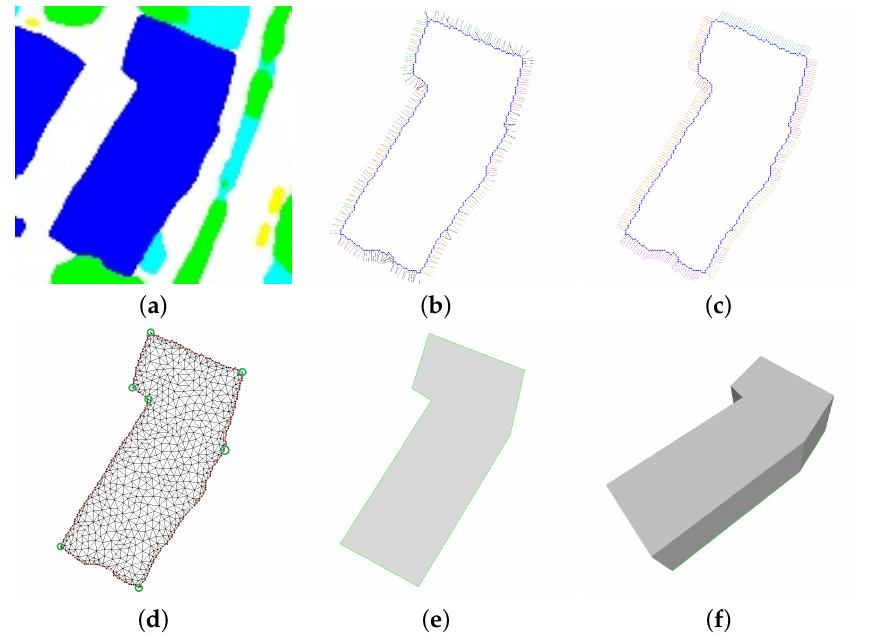
Figure 2. Overview of the proposed method of contour deformation based urban modeling. ( a ) is the input segmentation of a building from Figure 1. ( b ) detects the dominant directions from the bilaterally smoothed normals using RANSAC, five dominant directions are detected (color coded). ( c ) each edge is assigned with a target direction to align to with a Markov random field (MRF) formulation. ( d ) aligns the contour to the detected directions through our deformation optimization. ( e , f ) the generated vectorized building LOD0 model of polygon and LOD1 model extruded to the averaged height in